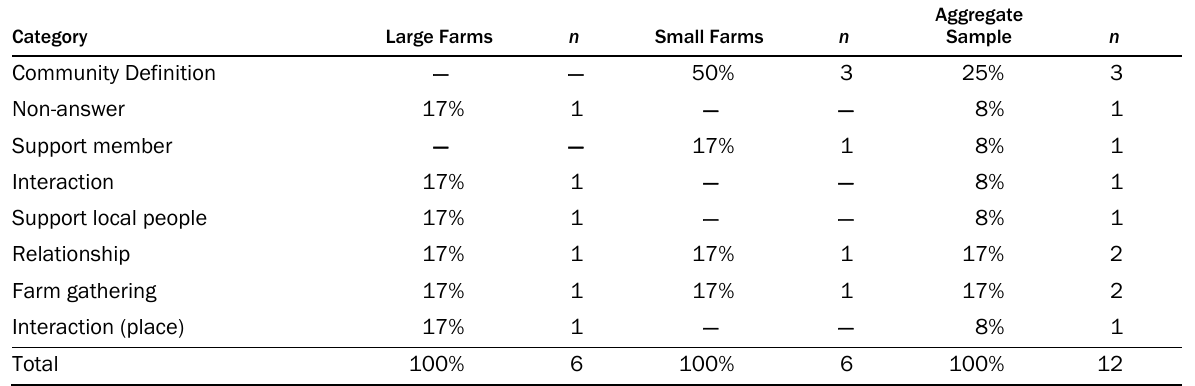
Table 7. What Does the Community in CSA Mean to Farm-owners?